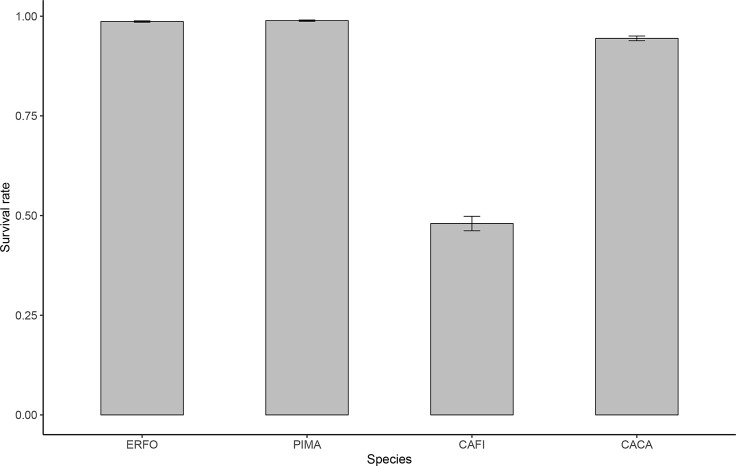
Means and standard errors of seedling survival at the plot level for E. fordii (ERFO), P. massoniana (PIMA), C. fissa (CAFI), and C. carlesii (CACA).